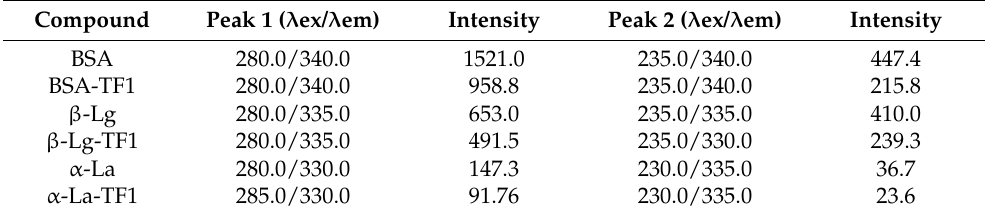
Figure 4. Three-dimensional fluorescence of BSA ( a ), β -Lg ( b ), α -La ( c ), BSA-TF1 ( d ), β -Lg-TF1 ( e ) and α -La-TF1 ( f ) systems at 298 K and pH 7.4. [BSA] = [ β -Lg] = 5 µM, [TF1] = 15 µM. Table 1. Three-dimensional fluorescence spectral characteristic parameters of BSA, β -Lg, and α -La their TF1